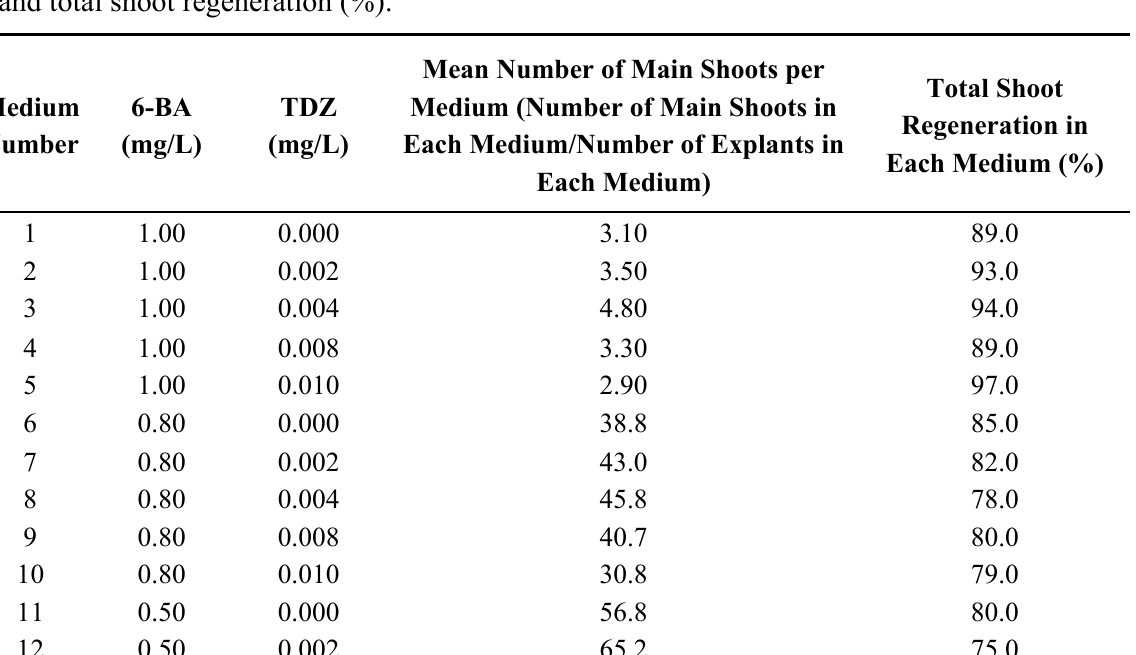
Table 1. The effect of N -6-benzyladenine (6-BA) and thidiazuron (TDZ) on the main shoot and total shoot regeneration